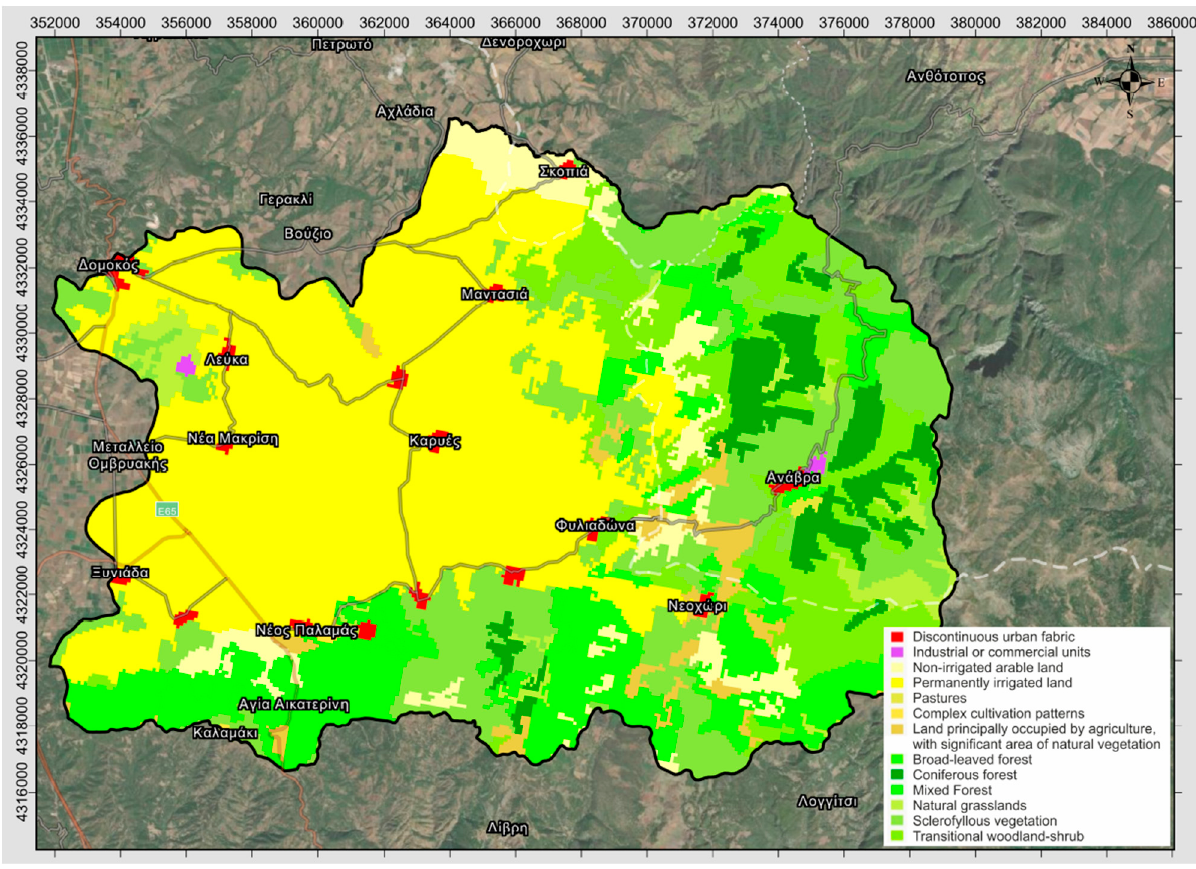
Figure 6. Land use map derived from CORINE [35] (see SM12).